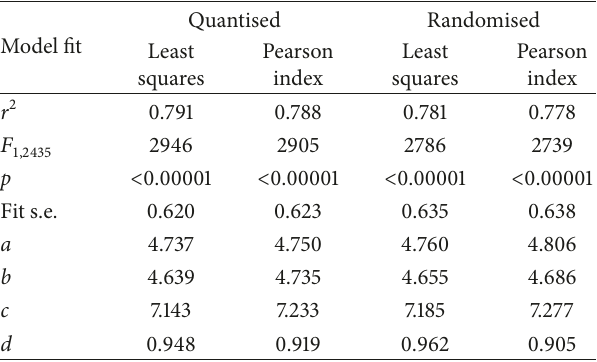
Table 4: Model parameters for the sigmoidal model of field pH against lab pH with least squares and Pearson index fit for the quantised and randomised